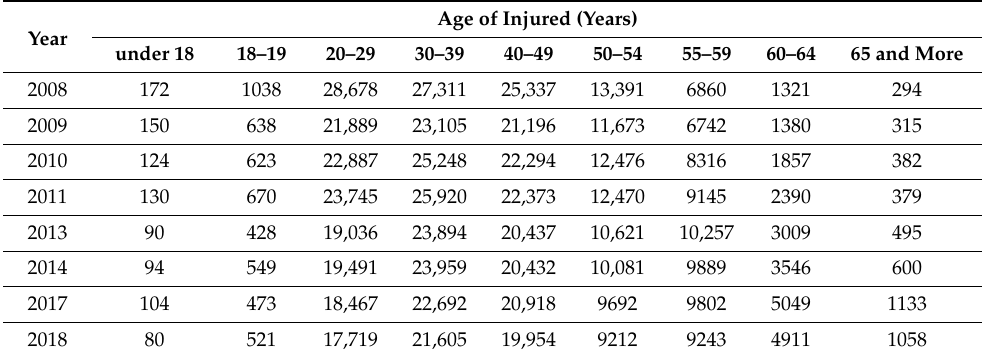
Table 2. Injured in accidents at work in Poland (own elaboration based on